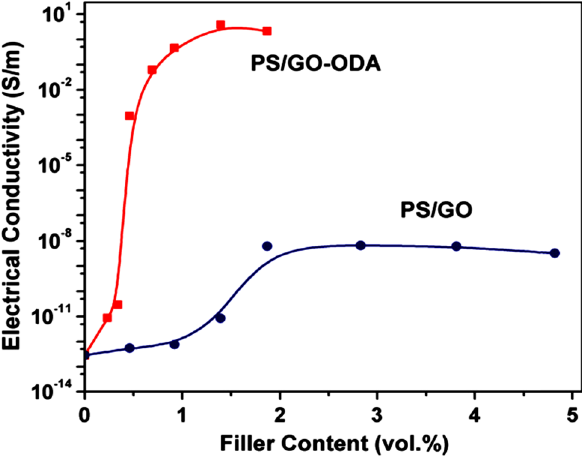
Figure 15: Electrical conductivity of polystyrene based nanocomposites as a function of fi ller content ( 125 ) . PS/GO – ODA – polystyrene/graphene oxide - octadecylamine; PS/GO – polystyrene/graphene oxide. Repro - duced with permission from